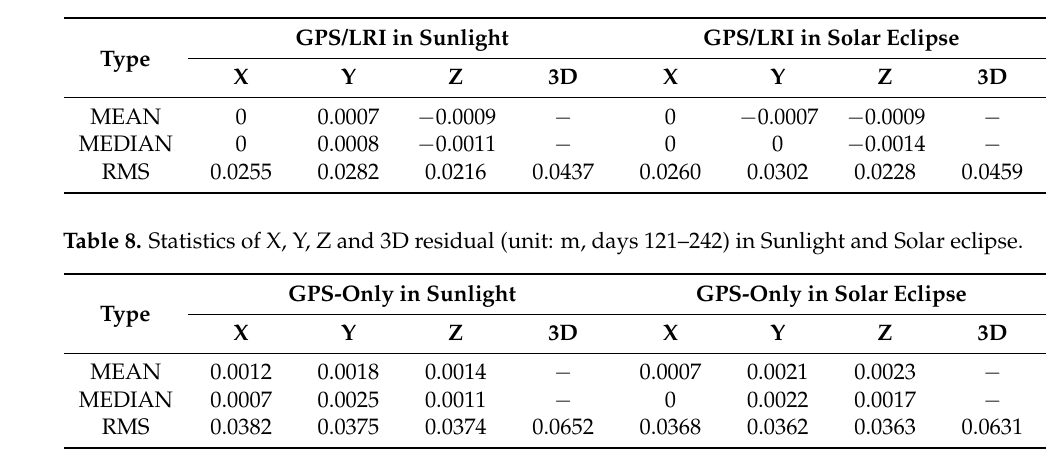
Table 7. Statistics of X, Y, Z and 3D residual (unit: m, days 121–242) in Sunlight and Solar eclipse.